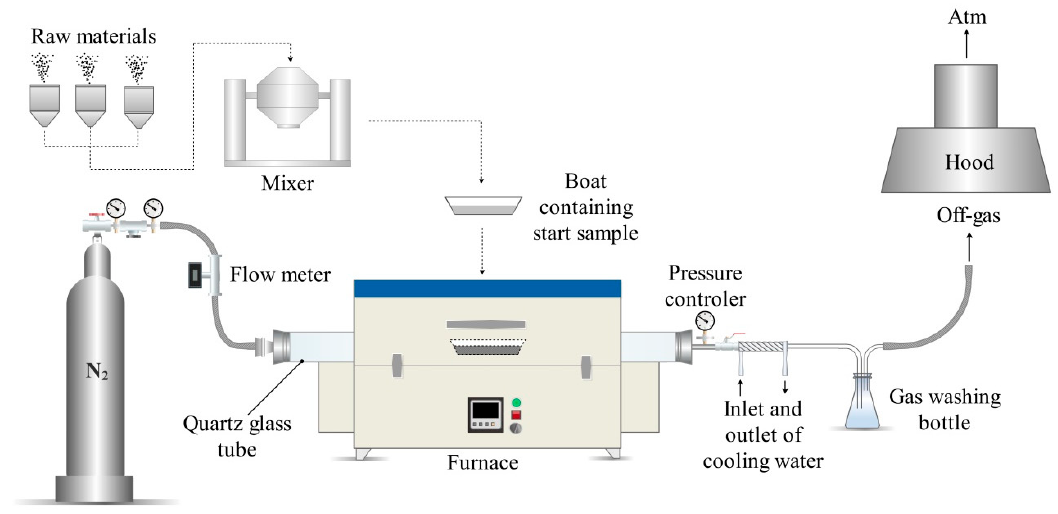
Figure 4. Schematic illustration of the experimental setup for the synthesis of WS 2 powder.